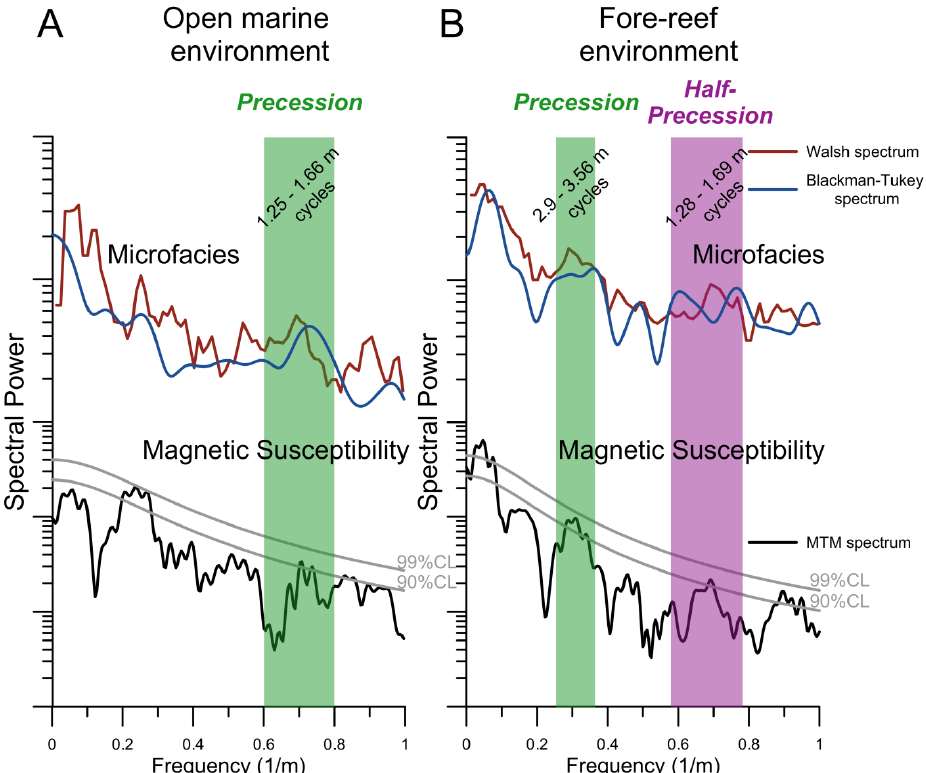
Fig. 3. Spectral analyses on the different depositional environments of the “La Couvinoise” section separately. (A) : spectral analyses on the microfacies series and Magnetic Susceptibility series of the lower part of the section (open marine environment). (B) : spectral analyses on the microfacies series and Magnetic Susceptibility series of the upper part of the section (fore-reef environment). CL=Confidence Limit.